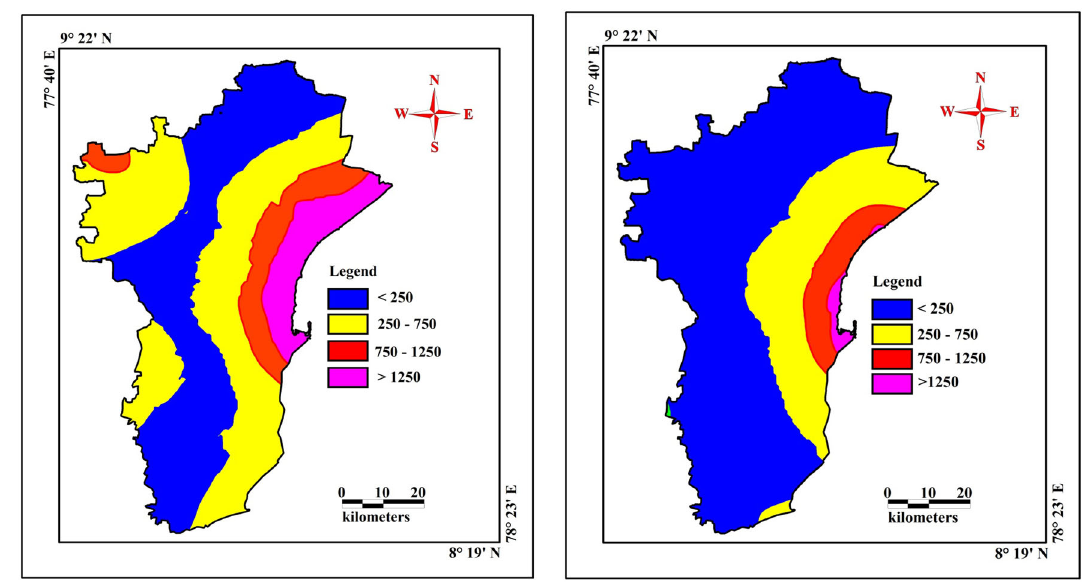
Fig. 6 Spatial distributions of chloride in the study area representing PRM and POM (all values in mg l - 1